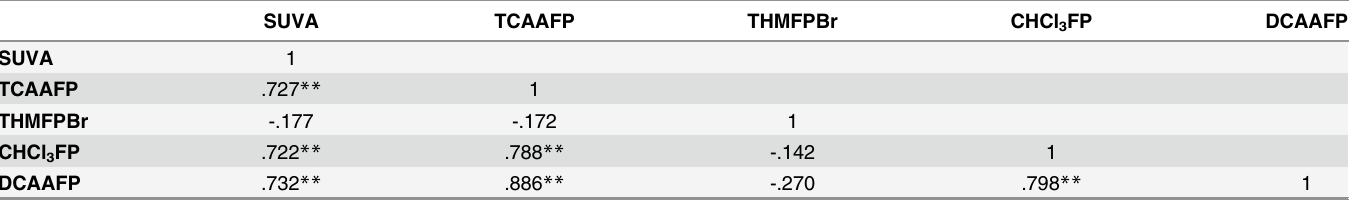
Table 2. Correlation matrix of SUVA index and four